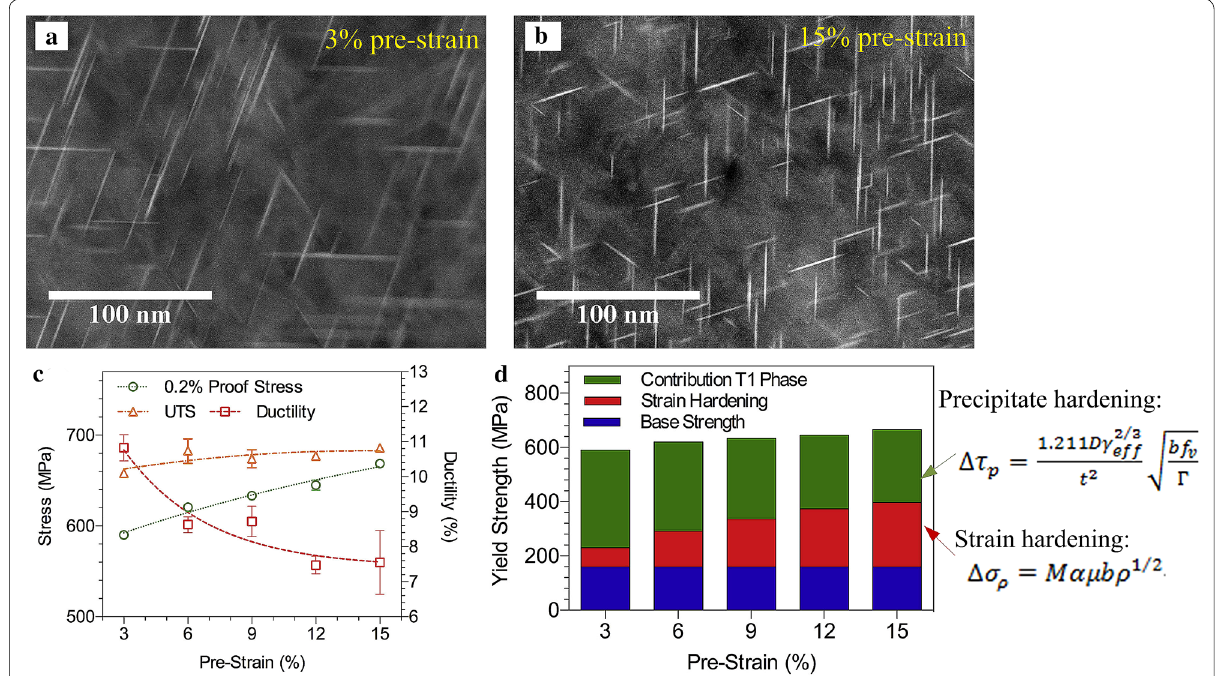
Figure 15 Ageing precipitation in 2195 alloy after: a 3% pre-strain, b 15% pre-strain, c the mechanical properties with different pre-strain, d quantitative analysis of strength contributions from the precipitate and strain hardening (Reproduced from Ref.